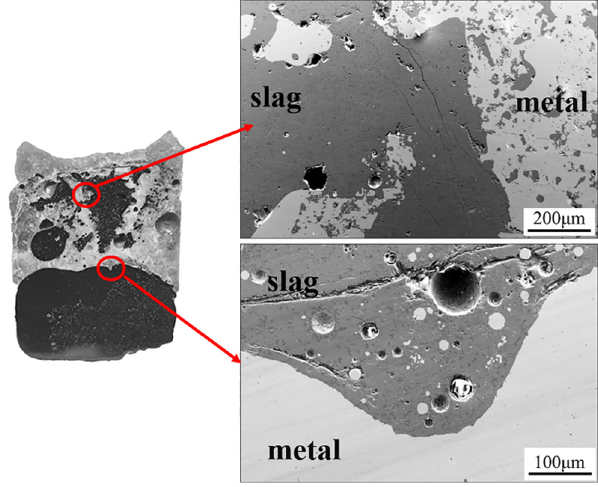
Figure 4. The interface morphology between Fe-5Al alloy and high SiO 2 flux after reacted at 1873 K for 7 min.